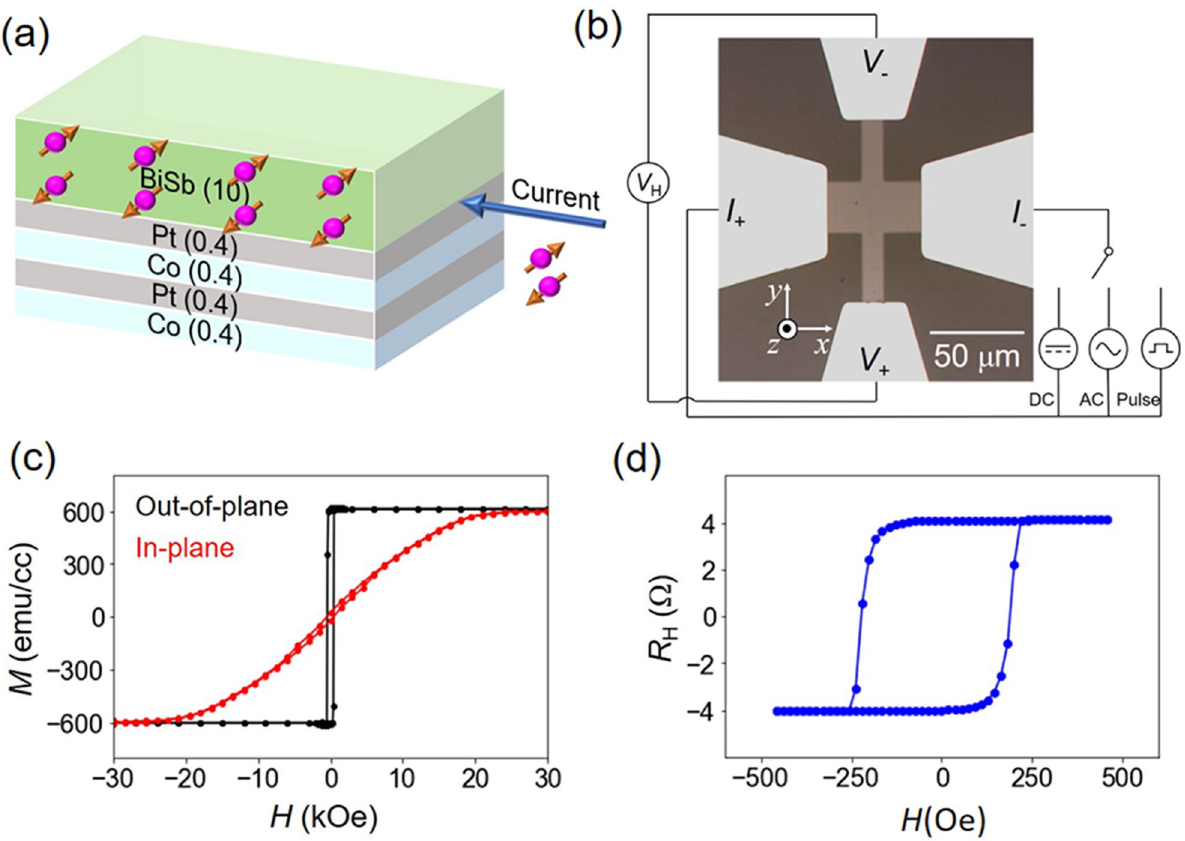
Figure 1. Perpendicularly magnetized Co/Pt ferromagnetic multilayers – topological insulator BiSb heterostructure. ( a ) Schematic structure of our multilayers. ( b ) Optical image of a Hall bar device and measurement configuration. ( c ) Magnetization curves of the Co/Pt multilayers. ( d ) Hall resistance of a Hall bar device measured with a perpendicular magnetic